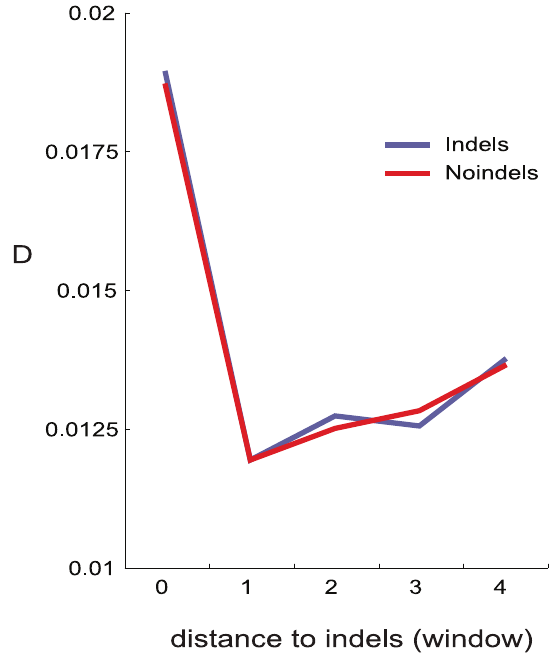
Figure 8. Human transcribed sequences accrue nucleotide substitutions in the sequence surrounding indels and their corresponding non-indel orthologous regions. Recent duplica- tions ( , 5% divergence) were aligned and non-duplicated orthologous regions from the Chimp genome were used as outgroups to allow identification of indel and non-indel haplotypes.